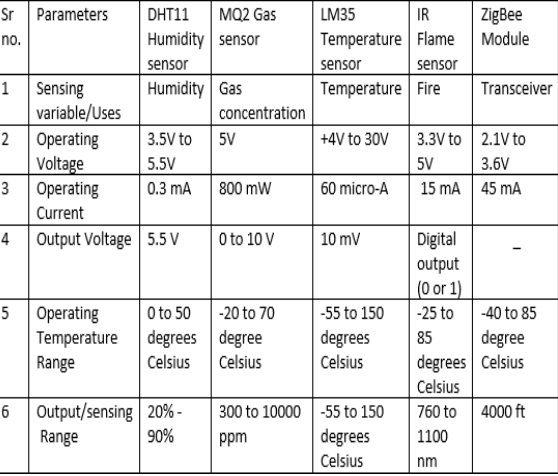
Fig. 1 : Block Diagram Of Coal Mine Safety And